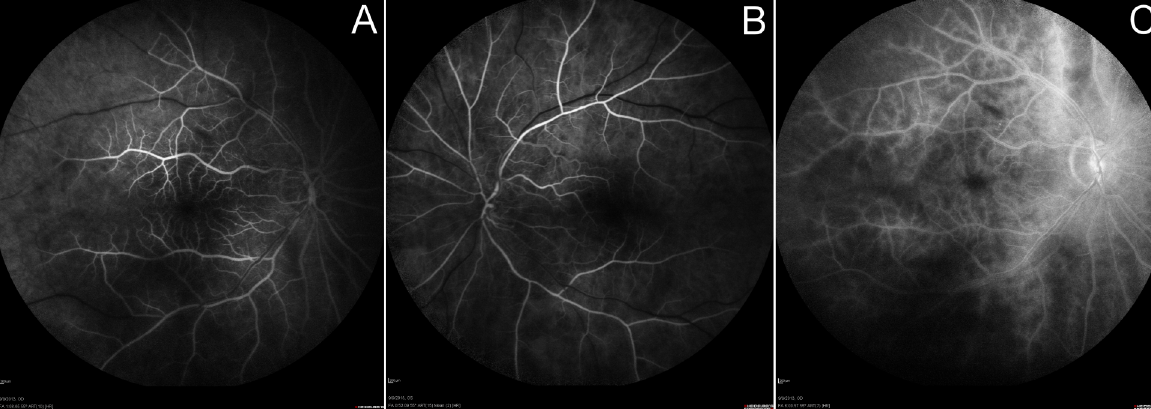
Figure 3: Fluorescein angiogram showing significantly delayed arterial filling with 60 seconds in the right eye (A) and 52 seconds in the left eye (B) and poor peripheral perfusion. Arteries are attenuated and veins are dilated and non-tortuous in both eyes. The late film (C) shows mild capillary leakage in the right eye at 6 minutes but no macular edema or